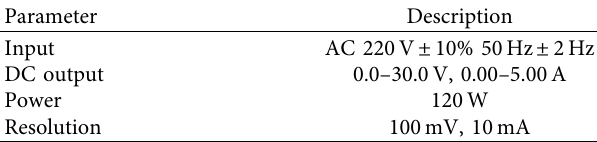
Table 4: Specifications of DC power supply for electrolysis. Parameter